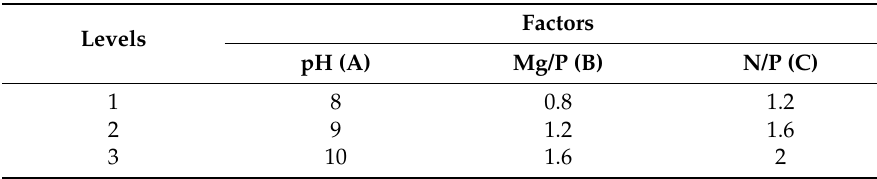
Table 1. Factors and levels in the orthogonal tests.